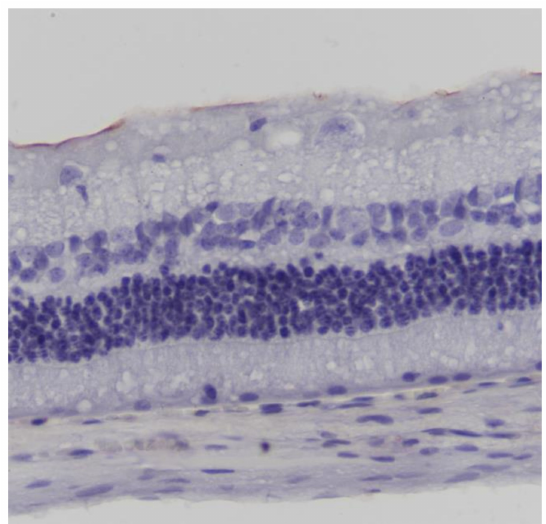
Figure 3. Group C. Negative (-) immunohistochemical staining. TNF-a × 200.